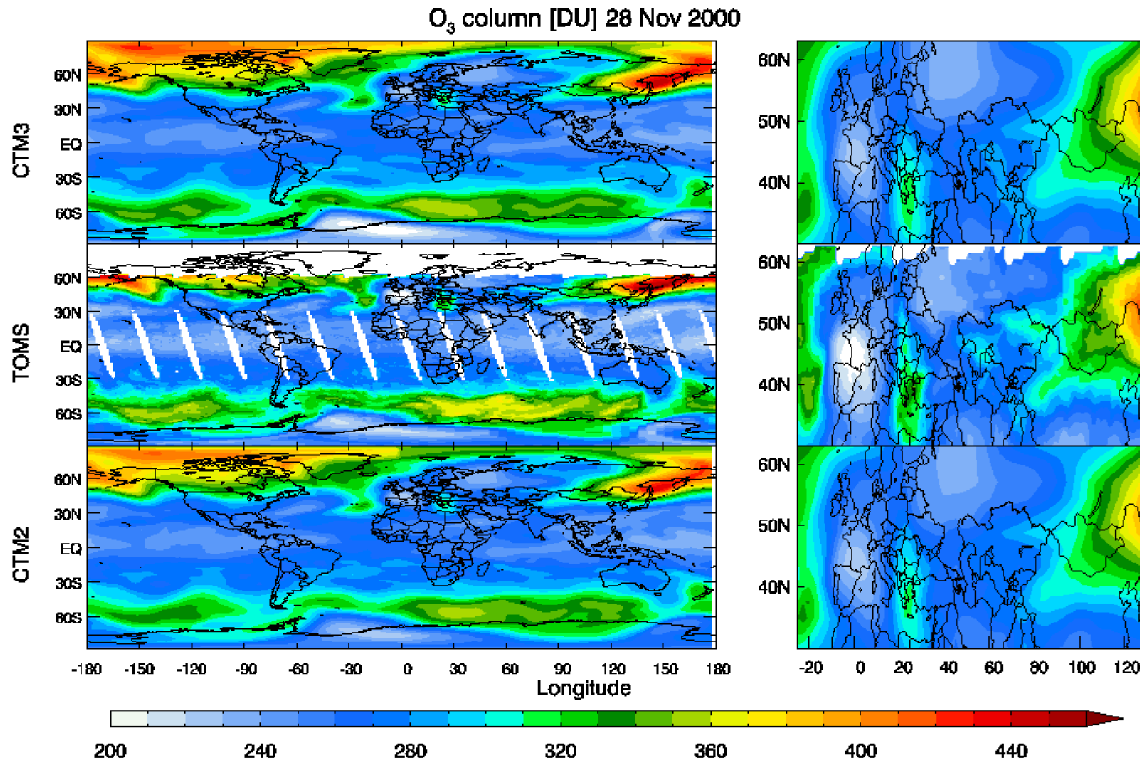
Fig. 6. Daily mean total O 3 column for C3 ssn (top), TOMS (middle) and C2 ssn (bottom), 28 November 2000.